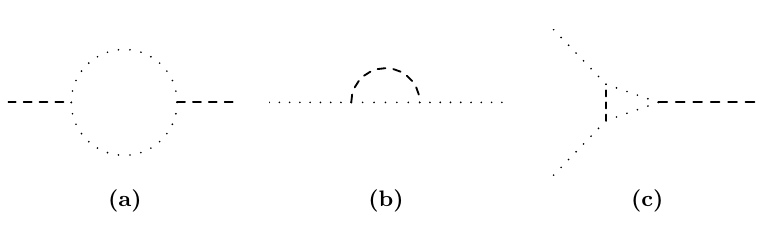
Figure 4. For the mixed dimensional scalar theory: (a) a 4d bulk scalar one loop self energy correction; (b) a 3d boundary scalar one loop self energy correction; (c) one loop vertex